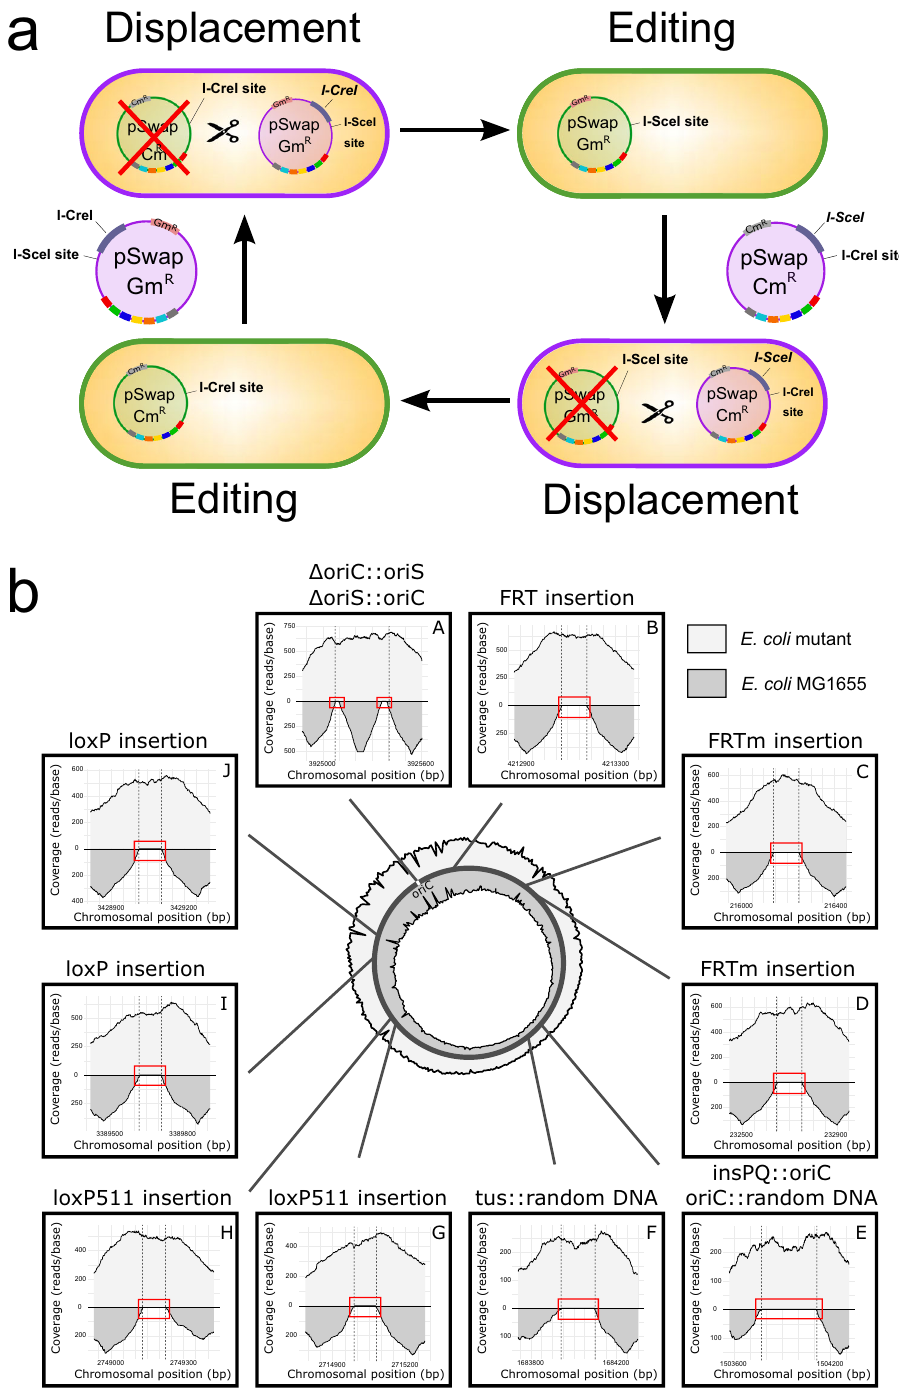
well as on glucose without DAP. On average, 83% of the tested clones were able to grow on all saccharides as well as without DAP (see Fig. 4d). This shows the high editing ef fi ciency of CRISPR SWAPnDROP even for up to four simultaneous edits and supports future extensions of the system by sgRNA arrays. Transfer of large chromosomal regions . CRISPR/Cas9-mediated excision of double-stranded DNA and homologous recombina- tion generally permit the handling and alteration of large DNA fragments in vivo 16 . CRISPR SWAPnDROP extends the handling of large DNA fragments to a systematic excise and